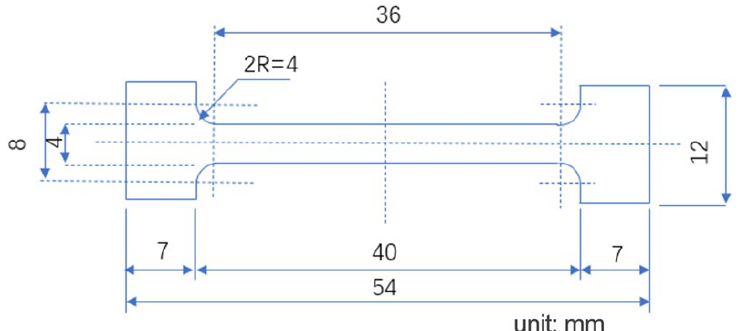
Table 1. Chemical composition of 2A14 aluminum alloy (wt.%).